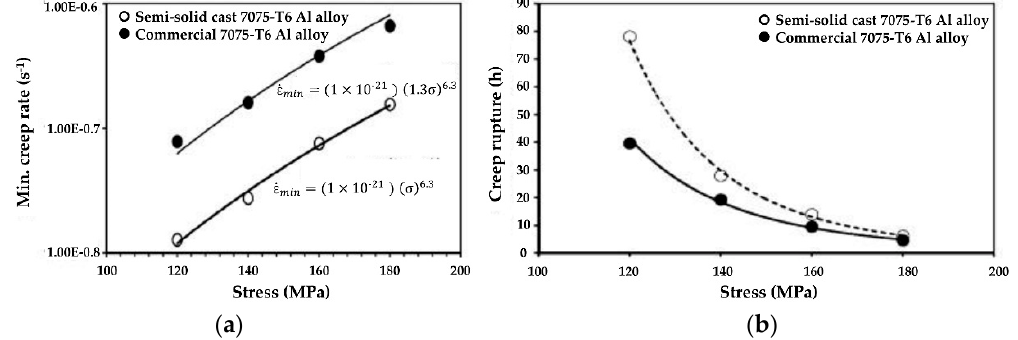
Figure 8. ( a ) The stress dependence of minimum creep rate and ( b ) creep rupture time [107], with permission from Elsevier, 2019. with permission from Elsevier,